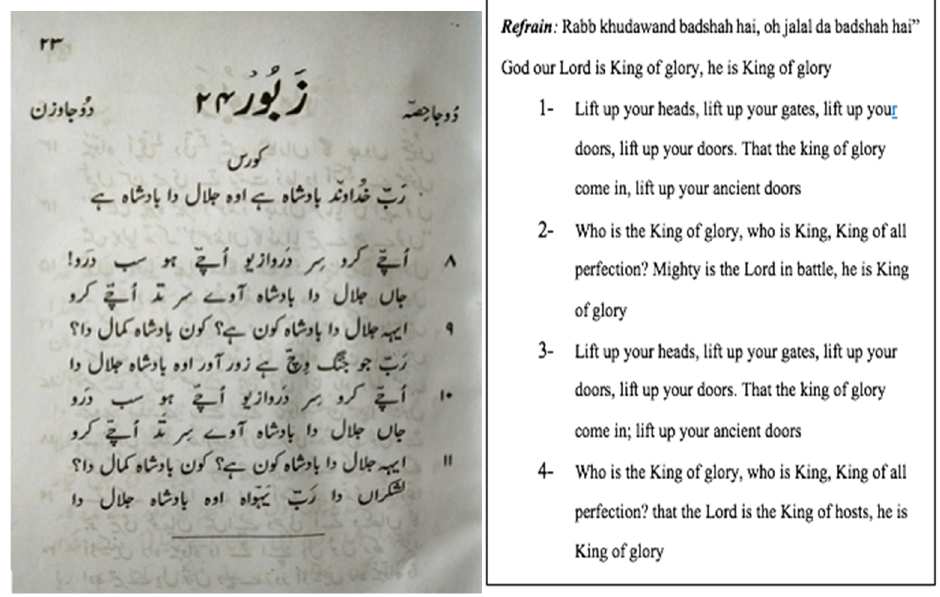
Figure 3. Urdu Text of Psalm 24:7–10, with English translation. Sialkot Convention Geet Ki Kitab , 56th Edition (Lahore: Nou Lakha Publications 2003, p. 23).